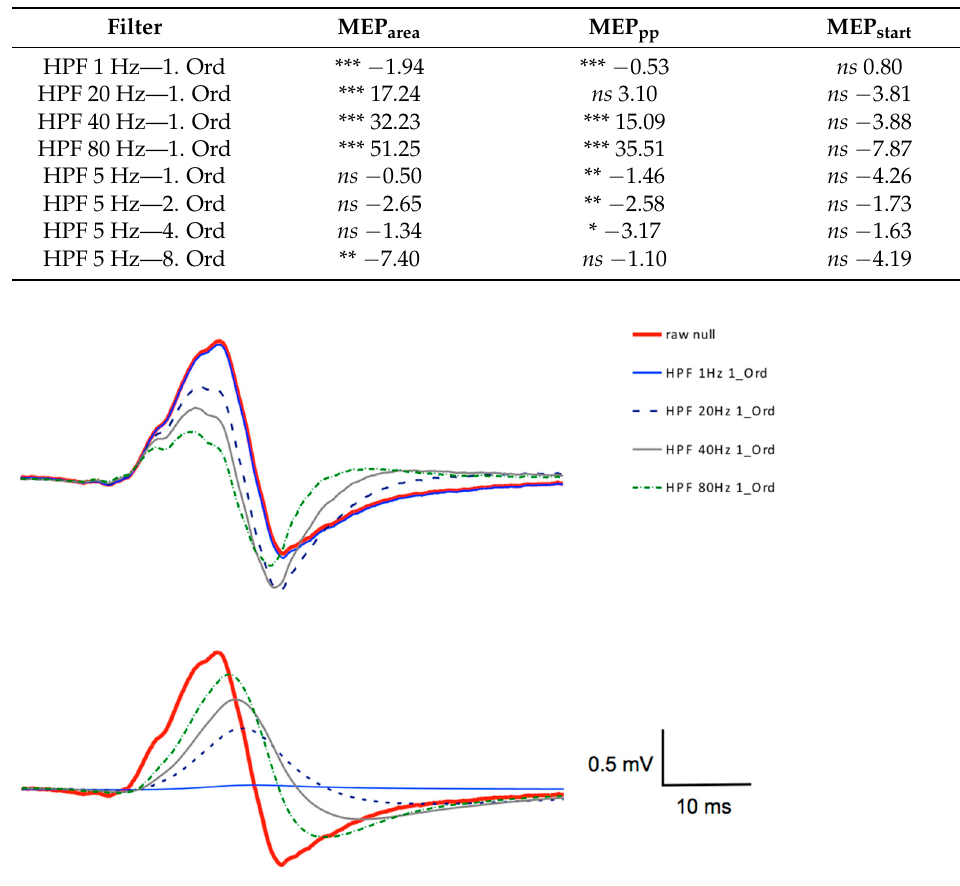
Figure 6. The single unfiltered MEP raw signal from a representative participant is shown as a continuous bold red line. The other signals (on the upper graph) were filtered with a 1st-order Butterworth HPF with different cut-off frequencies (1 Hz, 20 Hz, 40 Hz, and 80 Hz). The time window in this graph was 100 ms in duration. The graph shows the MEP signal 1 ms after TMS trigger. The lower graph shows the areas of deviation of the different filtered signals to the unfiltered MEP.